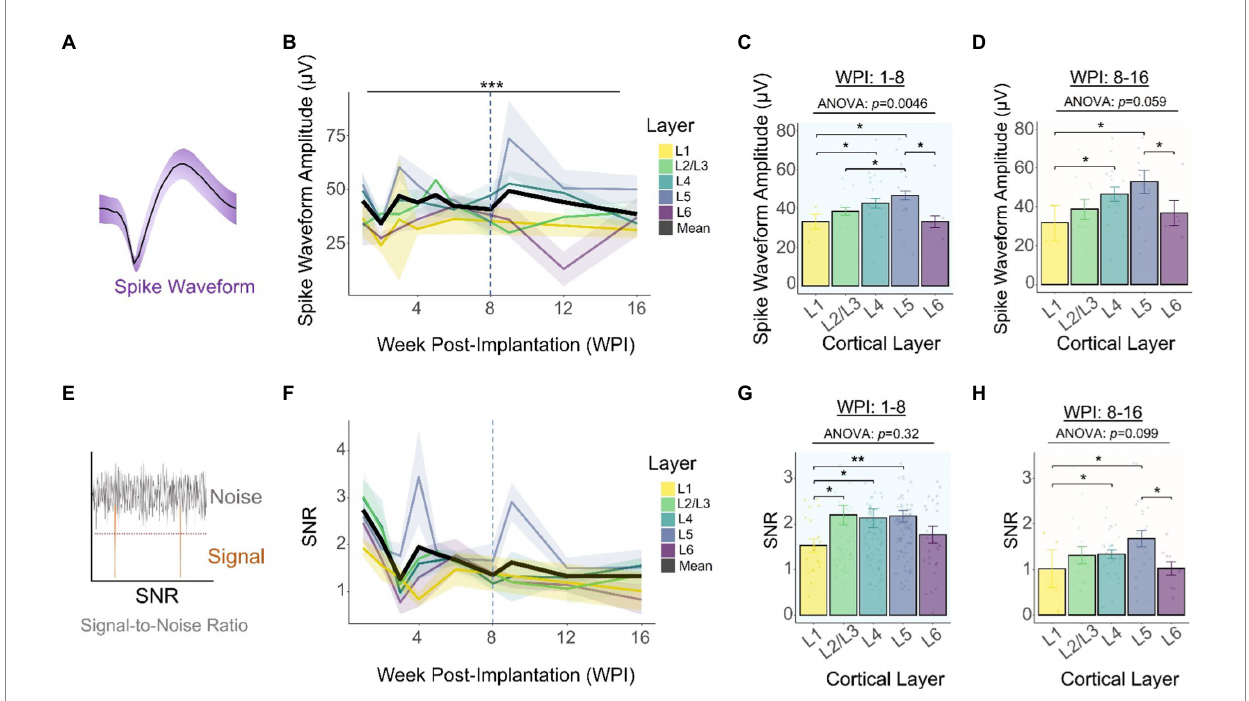
FIGURE 4 Chronic waveform amplitude and SNR stability across cortical layers. (A) Graphical representation of a spike waveform post-sorting. (B) Spike waveform amplitude across layers throughout the duration of the study. Top horizontal line represents an analysis of covariance (ANCOVA). To assess time-specific differences in spike amplitude across layers, the spike amplitudes of the (C) first (1–8 WPI) and (D) second (8–16 WPI) halves of the study were examined. (E) SNR was calculated by dividing the peak-to-peak amplitude over two times the noise amplitude (Eq. 2). (F) SNR across layers over time. Laminar quantification of SNR during the first (G) and second (H) half of the study. Analysis of variance and pairwise comparisons between layers (C, D, G, H) were performed with a one-way ANOVA and an unpaired t -test with Dunn–Bonferroni’s correction, respectively. * p ≤ 0.05, ** p ≤ 0.01, *** p ≤ 0.001. Shaded areas and error bars indicate mean ± SEM. ( N =